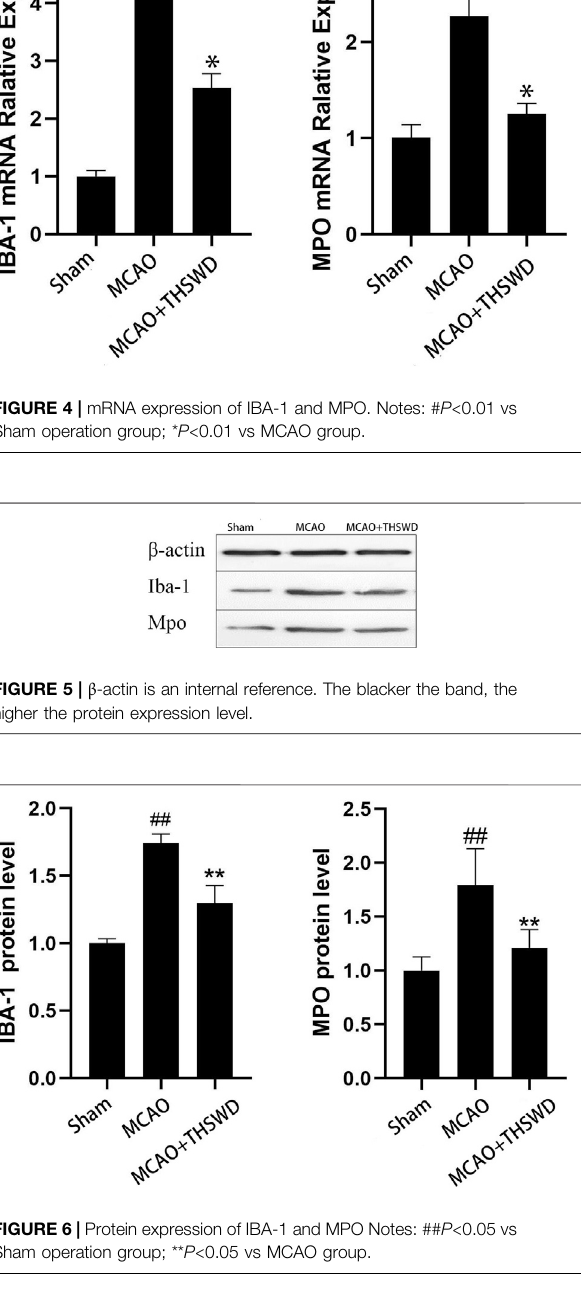
Frontiers in Pharmacology |